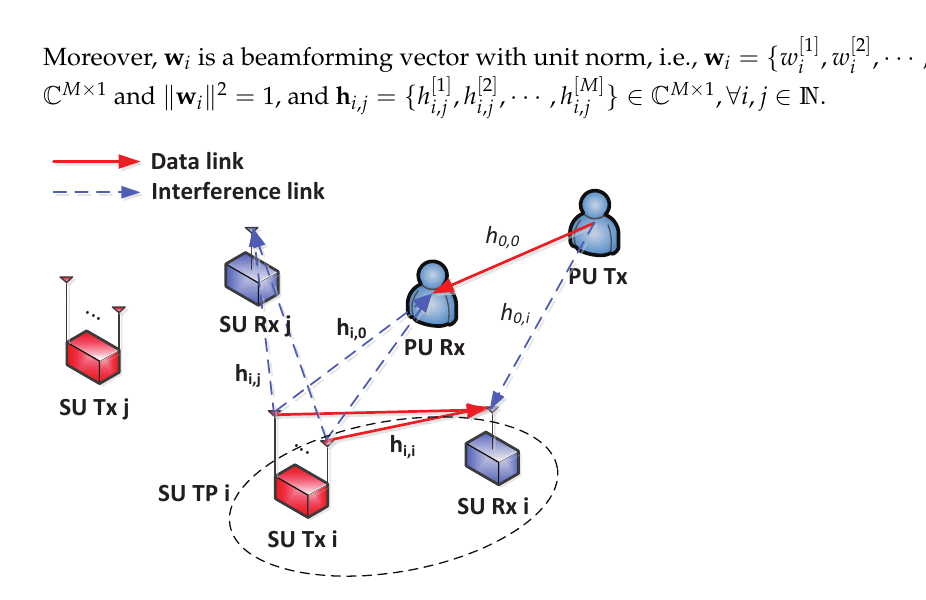
Figure 1. System model of heterogeneous networks with multiple-input-single-output (MISO) interference